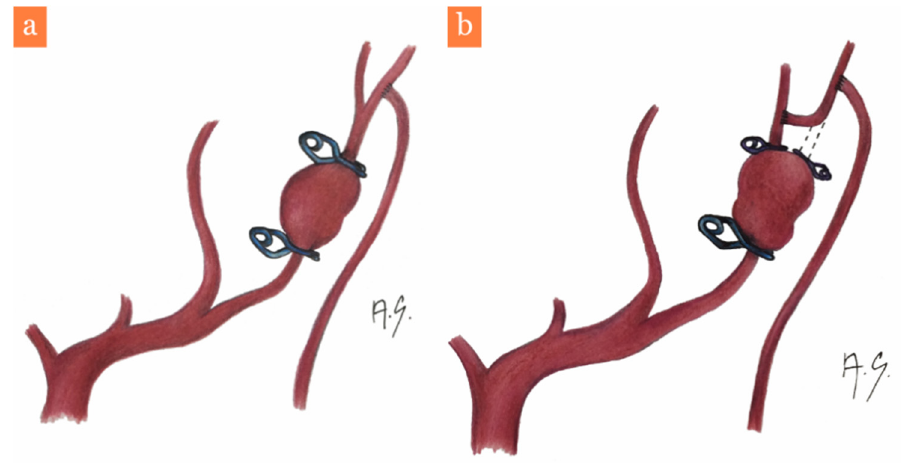
Figure 4. Artistic depiction of the bypass (drawn by Alena Sejkorová). ( a ) Our utilized STA-MCA M4 low flow bypass and M3 aneurysm trapping, ( b ) potential use of the STA-MCA M4 bypass along with reimplantation of the proximal M3 segment into the second branch in cases of two MCA branches exiting the aneurysm, the parietal M2 trunk and its branches are not involved.